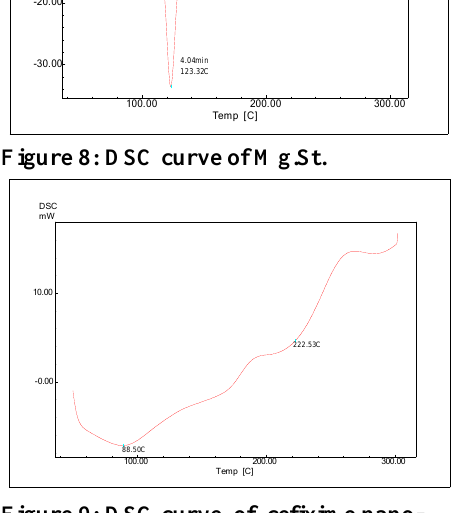
Figure 9: DSC curve of cefixime nano- crystals formula using PVP as stabilizer + Mg.St. (F6) .